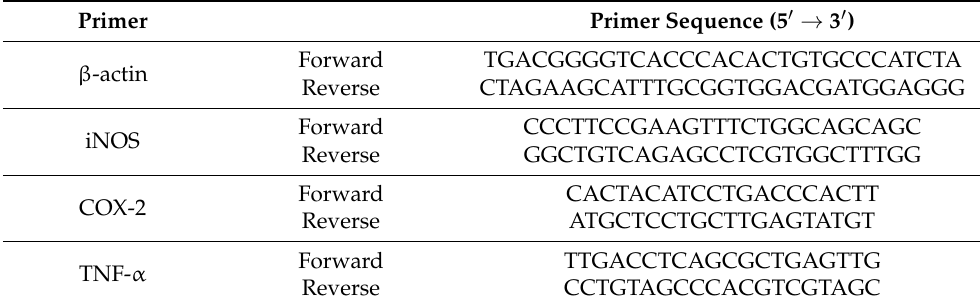
Table 5. Gene annotations and primer sequences used in RT-PCR